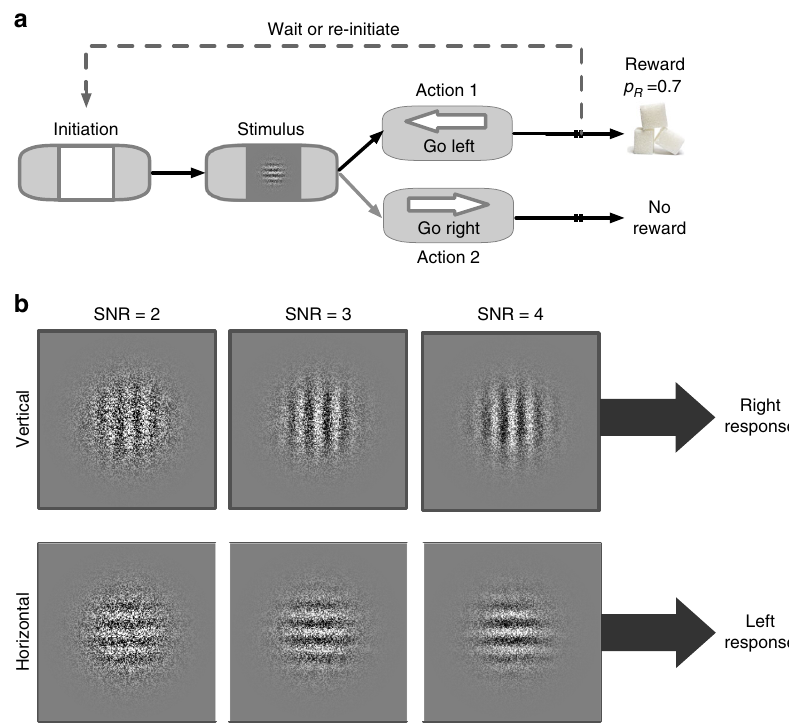
Fig. 1 Schematic of the experimental paradigm, visual stimuli, and stimulus – response rule. a Timeline of each trial in the learning under perceptual uncertainty task. The rat fi rst initiated a trial by nosepoking a white square in the center of the screen. The initiation stimulus then disappeared, and the rat was brie fl y presented (1 s) with a single horizontal (H) or vertical (V) Gabor patch masked by noise. Rats were required to report the dominant orientation (H or V) via nosepoke based on a complementary stimulus – response rule; e.g., H → left and V → right. Correct choices were rewarded probabilistically (on 70% of randomly selected trials), following variable delay times. After stimulus discrimination, rats could wait a self-timed delay in anticipation of reward or initiate a new trial. The initiation stimulus appeared on the touchscreen 2 s after a rat indicated its choice. b Examples of visual stimuli and one of the two stimulus – response rules. We refer to their discriminability as an SNR value re fl ecting the strength of visual signal (4, most discriminable; 3, moderately discriminable; 2, least discriminable). After discrimination of the visual stimulus, the rat makes a response (using the touchscreen) according to the rule H → Left and V →